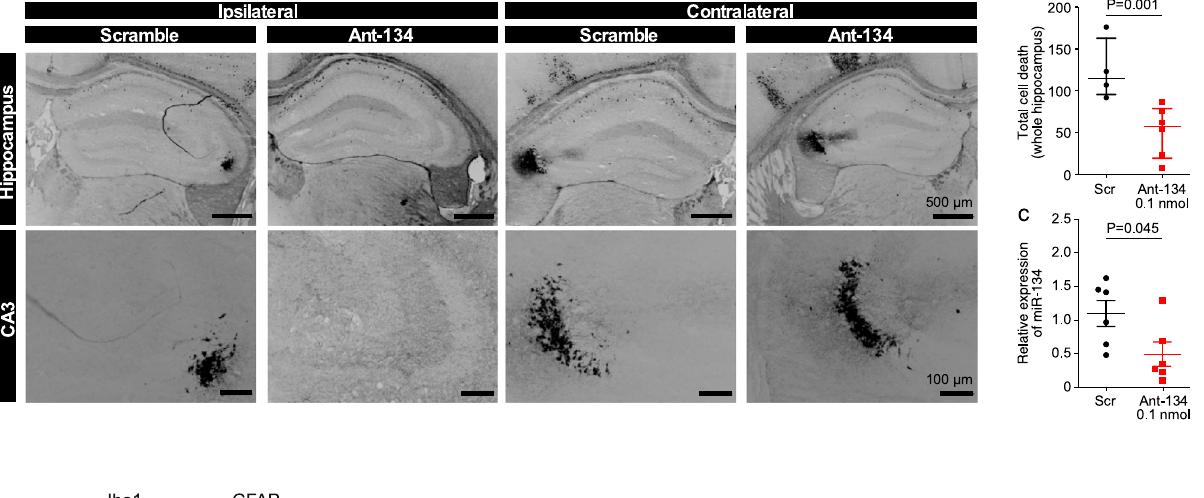
The anti-seizure effects of Ant-134 were apparent despite the observation that miR-134 was not upregulated following SE in P21 mice. While an increase in miR-134 levels is commonly reported after seizures 17,18 , we have previously reported that this is not required for the anti-seizure effects of Ant-134. For instance, Ant-134 potently reduces spontaneous recurrent seizures in rats despite unchanged miR-134 levels in the perforant pathway stimulation model 21 . Currently, the role of miR-134 in the immature brain is incompletely understood. It is unclear why KA seizures did not change transcription of miR-134 levels in the P21 mice but may be due to generalised or lower intensity seizures compared to those generated by either intraamygdala KA 18 or systemic